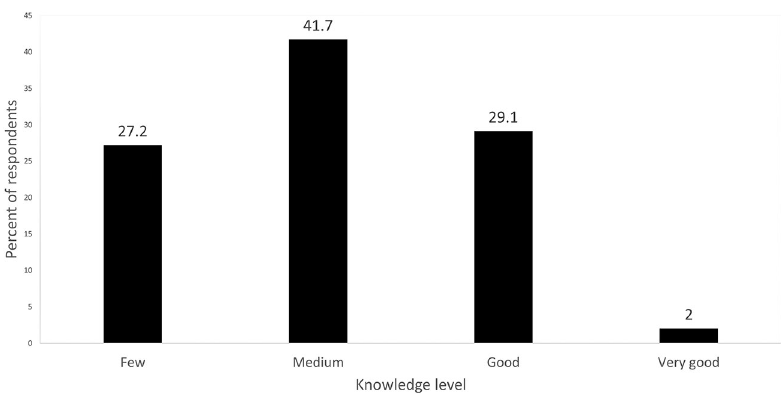
Figure 1. Respondents ’ knowledge level regarding herbal products sold in